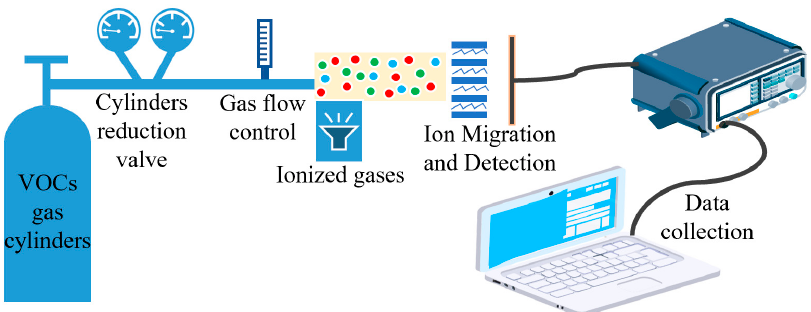
Figure 9. Schematic diagram of the test system.